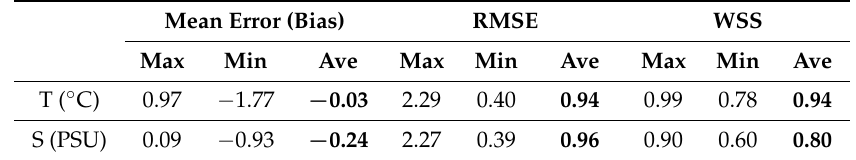
Figure 3. ( a ) Salish Sea model domain and finite-volume grid; ( b ) monthly water-quality monitoring stations from Washington State Department of Ecology. Table 1. Salish Sea model overall error statistics and skill score for temperature and salinity calibration data for the year 2014 from monthly monitoring profiles.